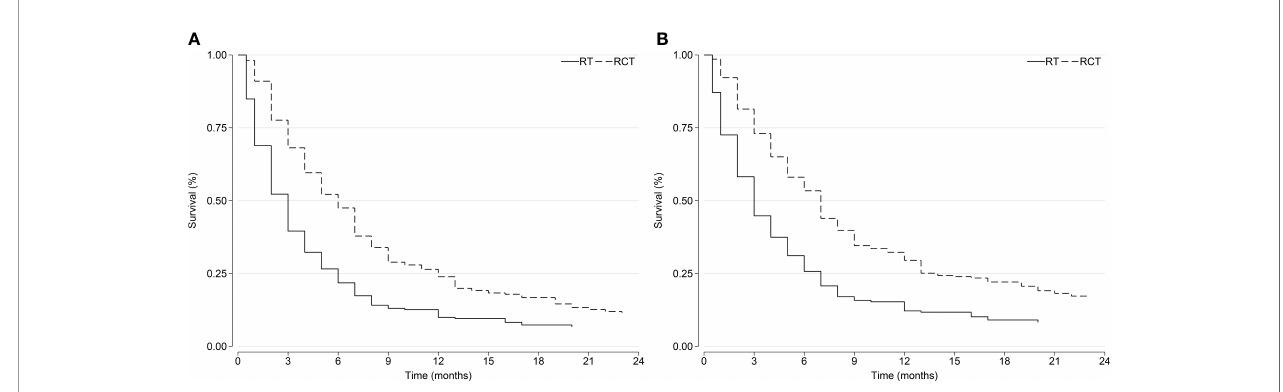
FIGURE 2 | Overall survival and cancer-speci fi c survival curves after the inverse probability weighting: (A) overall survival and (B) cancer-speci fi c survival. RCT, radiotherapy plus chemotherapy; RT, radiotherapy alone.